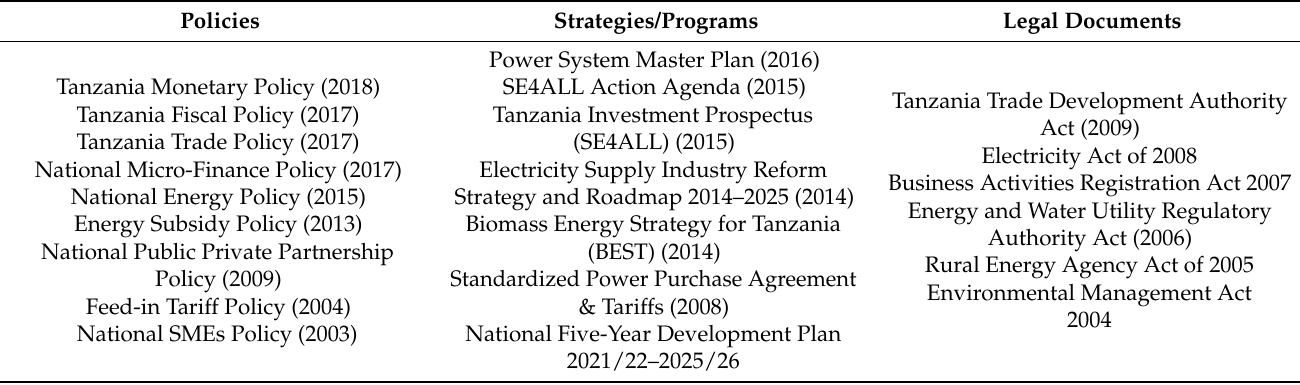
Table 7. Policies, strategies/programs and legal documents in the enabling